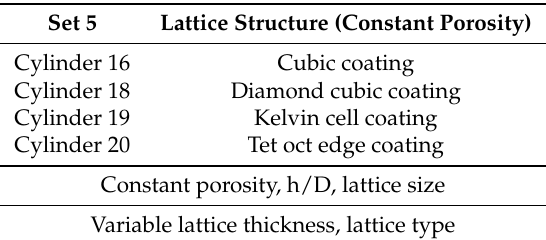
Table 5. Cylinders for experiment set 5.